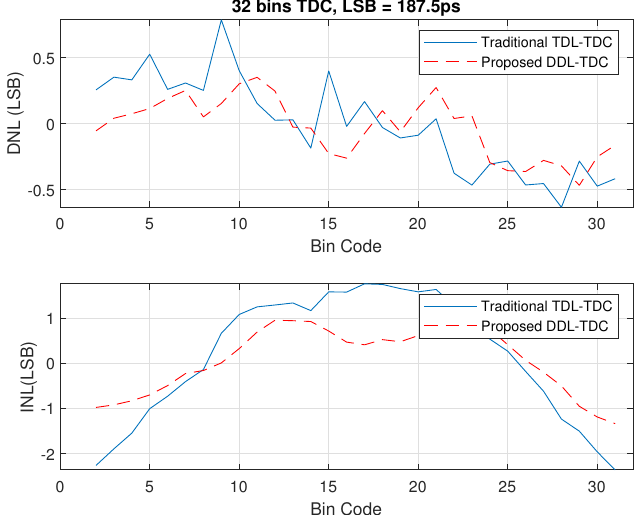
Figure 9. INL/DNL values obtained using the proposed DDL-TDC with 5-bit digital output.